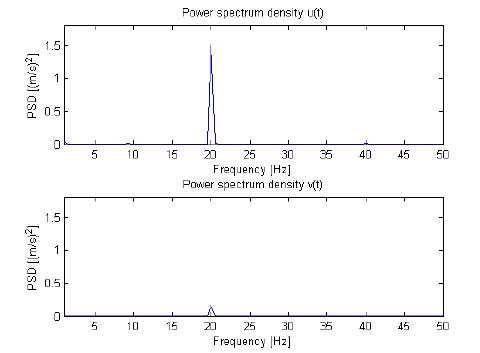
Fig. 11b. ϕ=π . Freq. spectrum at point X for regime II.